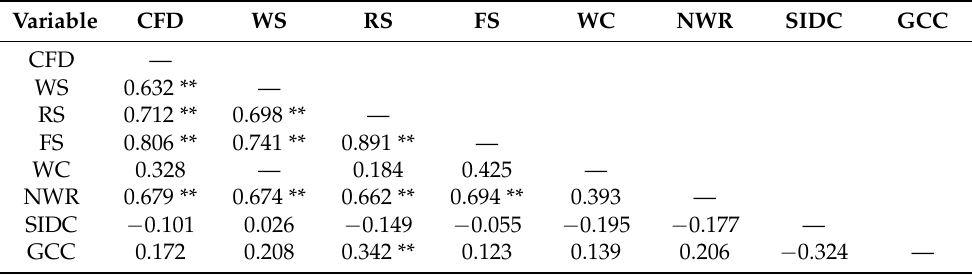
Table 1. Correlations among